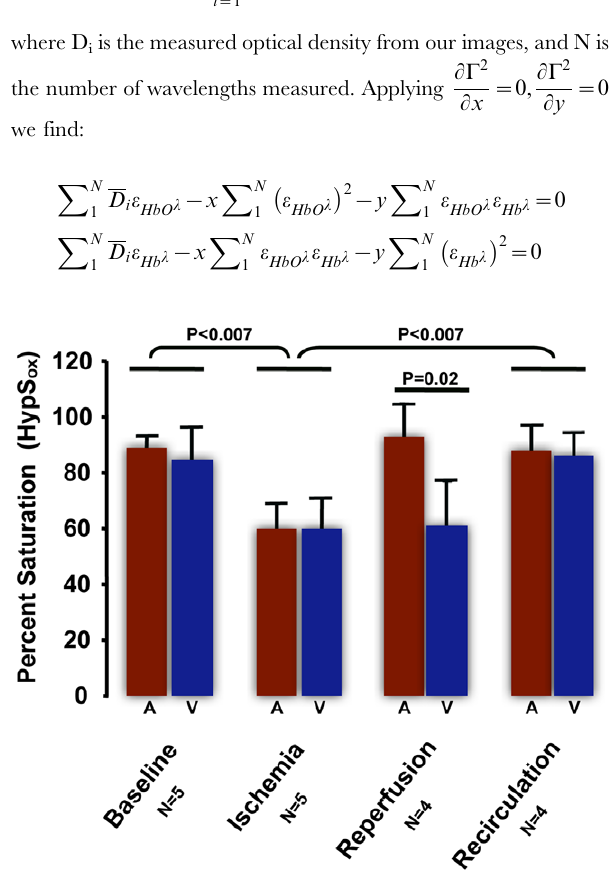
Figure 5. Summary results from 5 ischemia-reperfusion experi- ments (as described in Figure 4) with average arterial (A) and venous (V) HypS ox measurements for each condition. Compar- isons are made with Student T-test as shown.